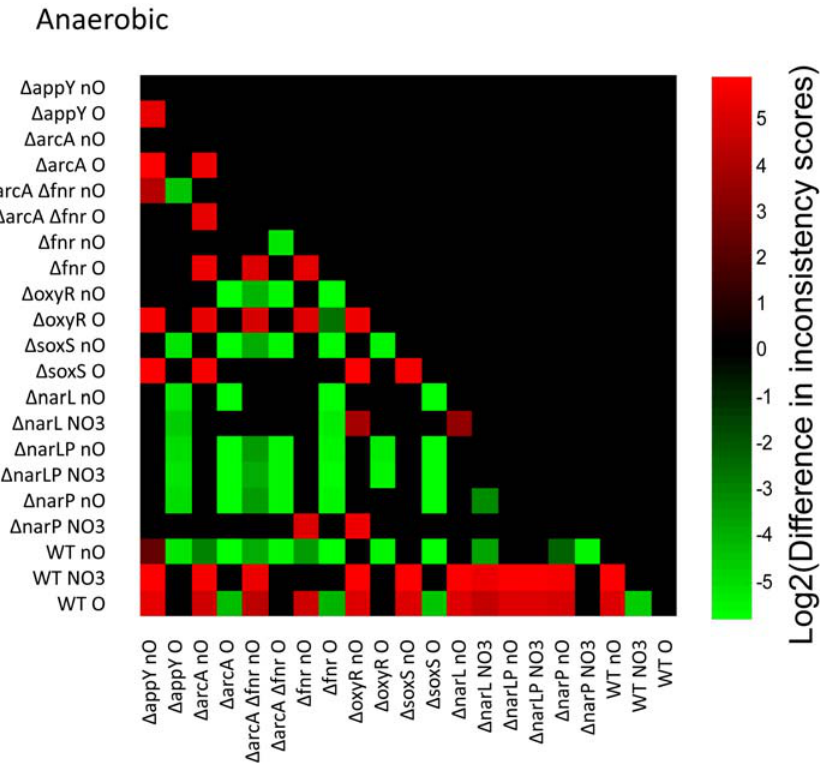
Figure 7. Pairwise comparisons of consistency for anaerobic conditions. A graphical representation of the log2 transform of the difference between inconsistency scores. A green box indicates that the sample on the y -axis is more consistent with anaerobic growth than the sample on the x -axis. Red boxes indicate the opposite. Differences that do not meet p , 0.05 are left blank. The shade of red or green quantifies the log2 of the difference in inconsistency scores. The position of green and red blocks shows that in nearly all cases that are statistically significant, gene expression data for strains grown without oxygen is more consistent with efficient anaerobic growth than strains grown with oxygen.